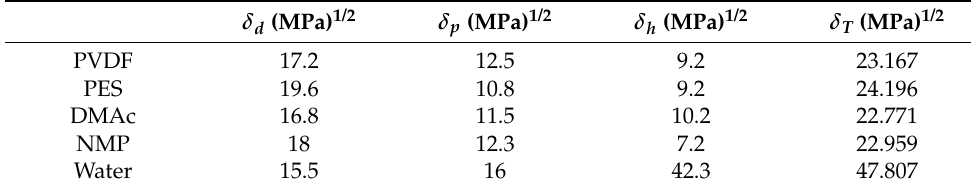
Table 2. Hansen’s solubility parameters at 298 K [23].